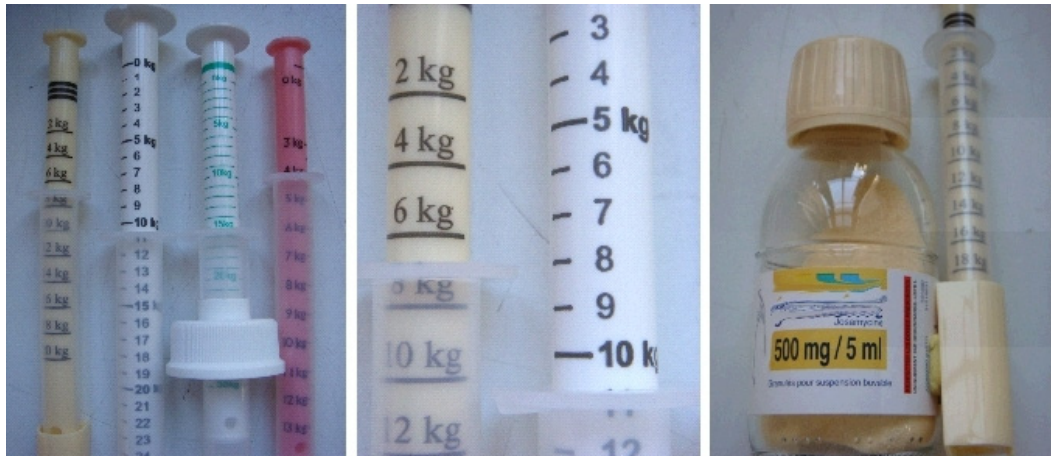
Figure 6. Examples of different syringes used for dosing pediatric